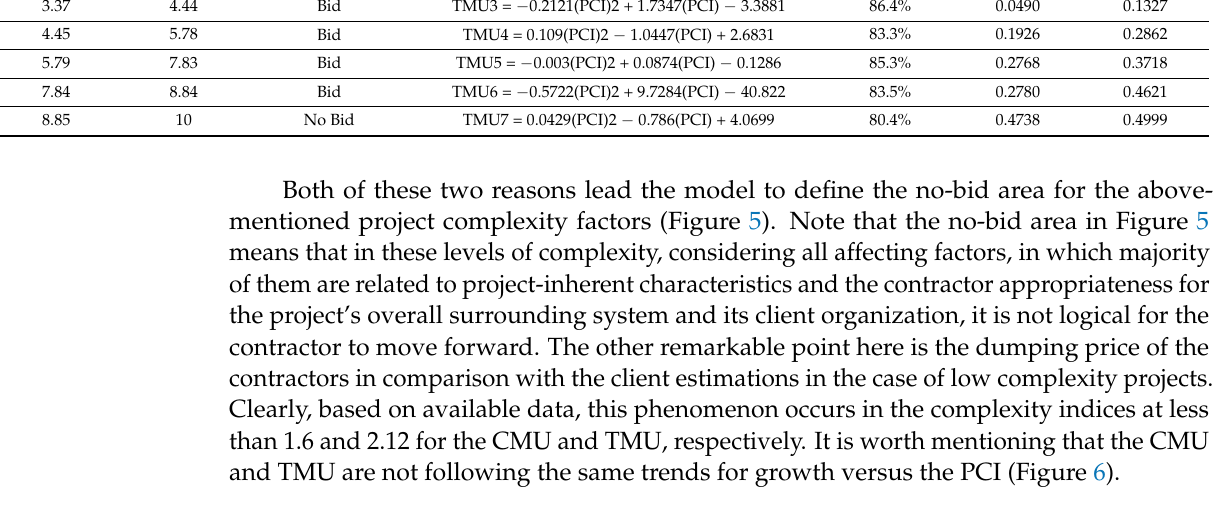
Figure 6. Trend of changing the upper and lower limits of the CMU ( left ) and TMU ( right ) without the no-bid area.